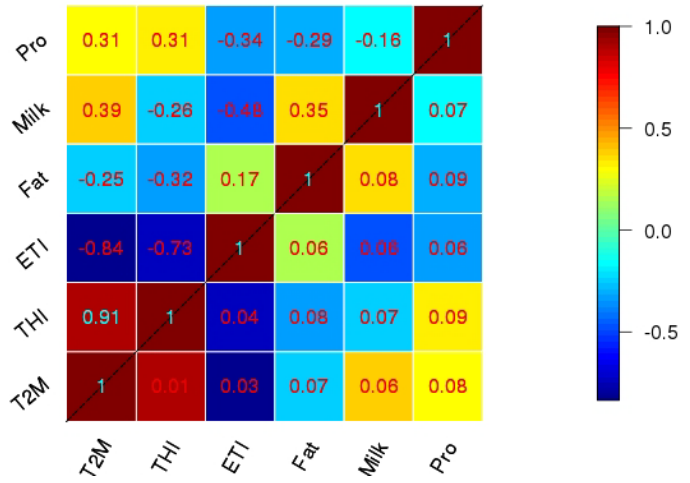
Figure 6. Correlation (above diagonal) and respective interquartile range of bootstrap sample (below diagonal) between milk compounds and climatic indices in